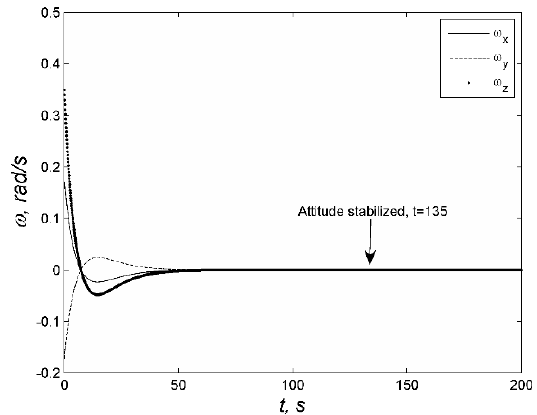
Figure 6. Relative angular velocity with respect to the target.